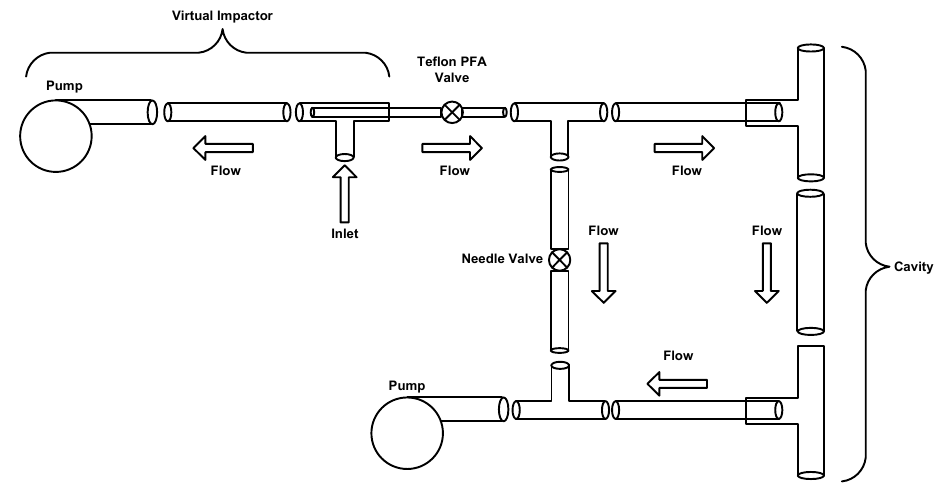
Fig. 5. Schematic diagram of the HCl sensor gas flow system. The virtual impactor, indicated on the left, serves to remove large particles from the main sampling flow. The optical cavity is indicated on the right.